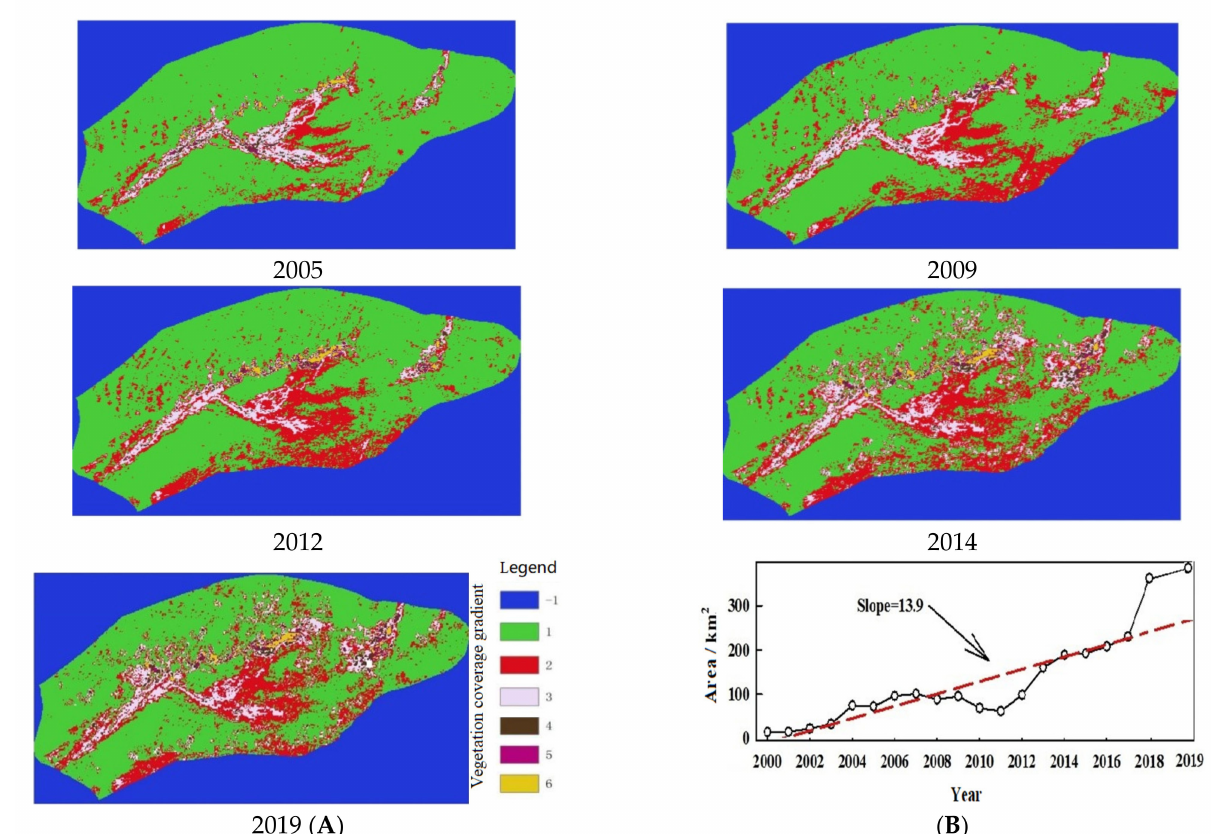
Figure 3. Vegetation coverage ( A ) and vegetation area ( B ) of the terminal of the Tarim River. − 1: The area outside of the terminal lake. 1: Sandy land (vegetation coverage <10%). 2: low coverage (10–20% vegetation coverage). 3: medium and low coverage (vegetation coverage is 20–40%). 4: Medium coverage (vegetation coverage is 40–60%). 5: medium and high coverage (vegetation coverage is 60–80%). 6: High coverage (vegetation coverage >80%).